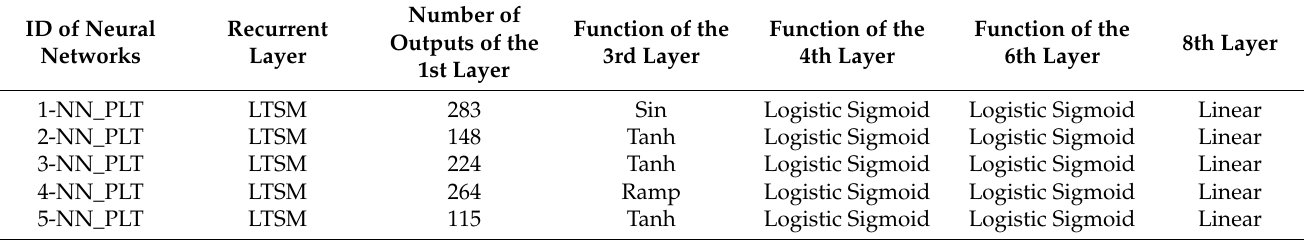
Table 1. Retained neural networks for predicting platinum prices.